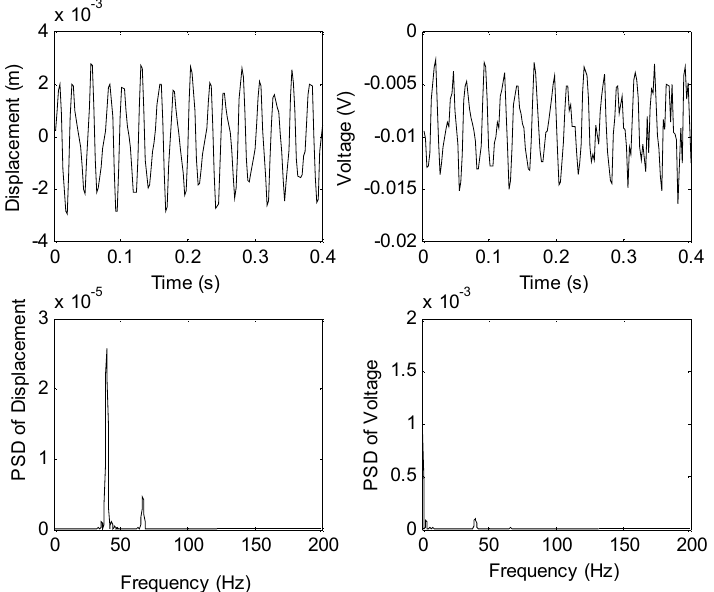
Fig. 21. Steady-state time history and frequency spectrum plots for vertical blade tip displacement and PZT sensor voltage at f = 40 Hz. A sinusoidal vertical step force of 40 Hz is acting at the tip of the blade where PZT sensor is mounted. that can occur due to torsional